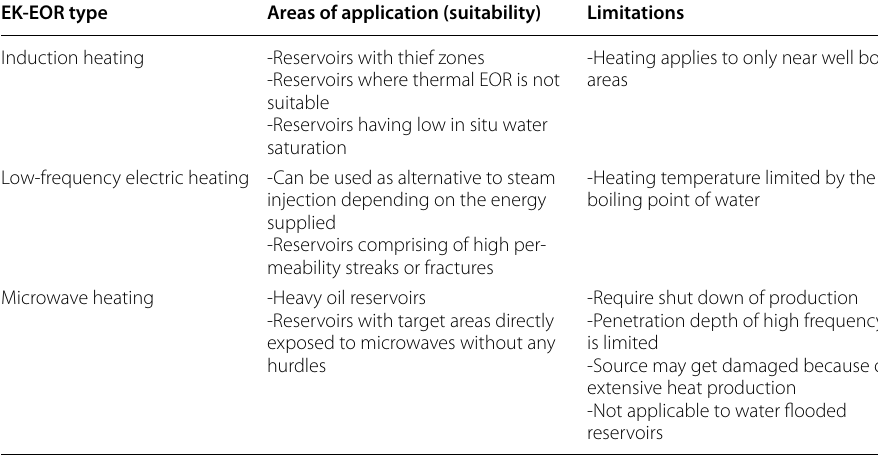
-Heating applies to only near well bore areas